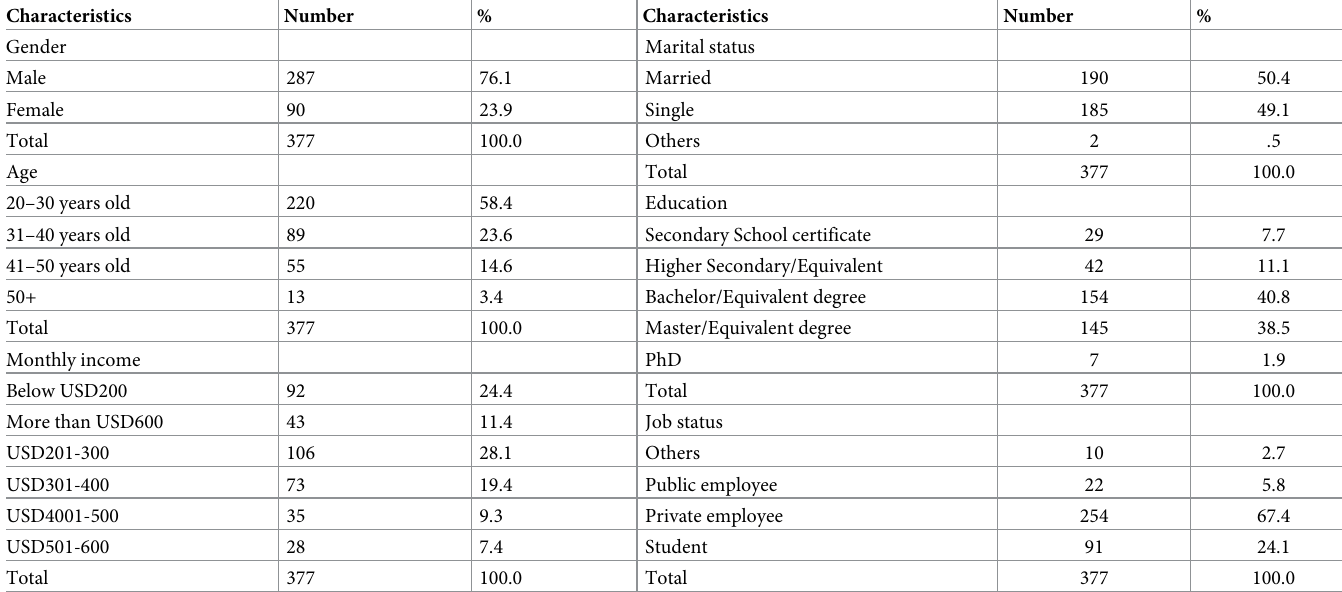
Table 1. Demographic